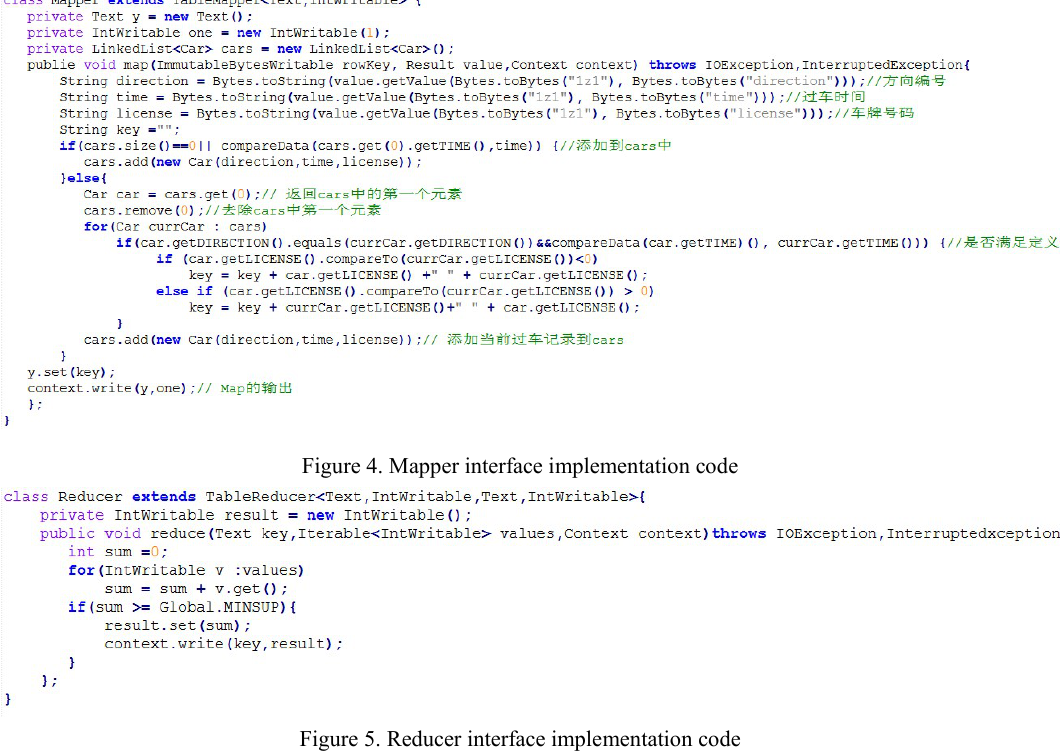
Figure 4. Mapper interface implementation code